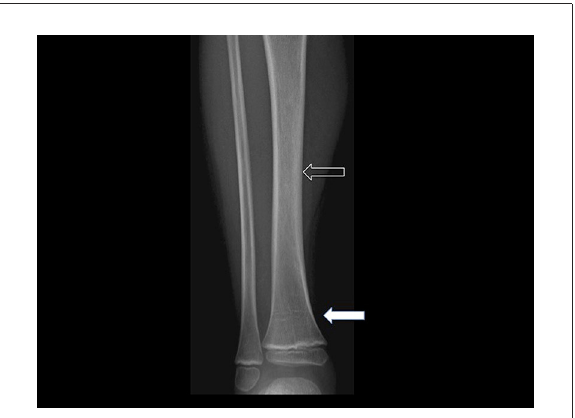
FIGURE1 Frontal radiograph of right leg demonstrates multiple transverse growth recovery lines (solid arrow) and inhomogeneous density of tibial diaphysis (open arrow). These findings were not initially